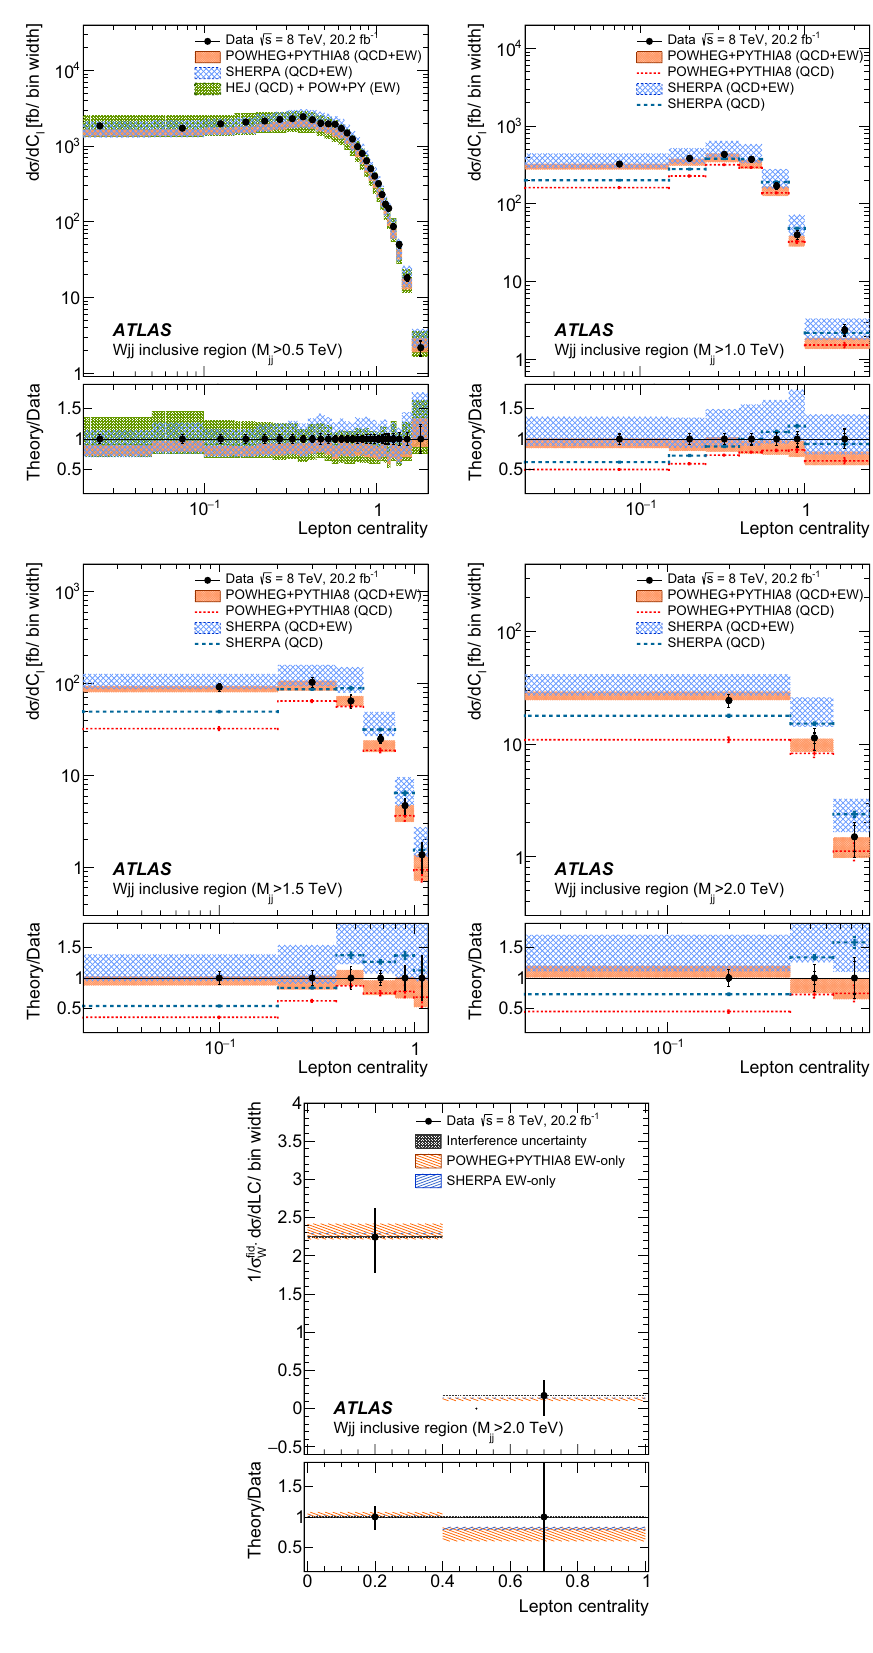
Fig. 39 Unfolded differential W jj production cross sections as a function of lepton centrality in the inclusive fiducial region with four thresholds on the dijet invariant mass (0.5, 1.0, 1.5, and 2.0 TeV). The bottom plot shows the normalized distribution for M jj > 2 . 0 TeV. Both statistical ( inner bar ) and total ( outer bar ) measurement uncertainties are shown, as well as ratios of the theoretical predictions to the data (the bottom panel in each